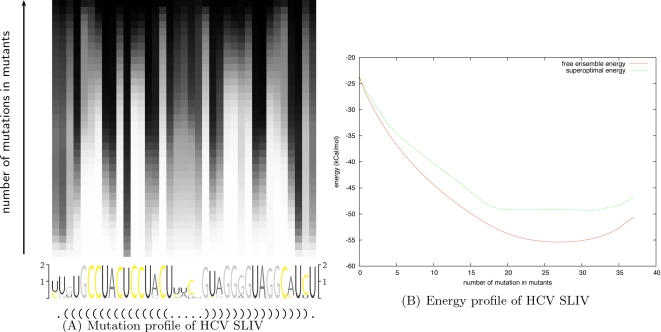
Complete mutation landscape of Hepatitis C virus stem-loop IV (HCV SLIV).(A) Mutation profile of HCV SLIV, averaged over all 110 seed sequences from Rfam, which depicts the probability of mutation of a residue at a level k (i.e. among all k-point mutants). This profile corresponds to a 37×37 matrix M = (mx,y), where x denotes the position within the input HCV SLIV sequence (x-axis) and y denotes the mutation level or number of mutations (y-axis). Mutation frequency computed from sampled structures is represented as a gray level: probability of 1 is depicted as black while probability of 0 is depicted as white, and values of y increase from bottom to top. Sequence logo and the consensus secondary structure from the Rfam seed alignment appear below the mutation profile. (B) Superposition of k-superoptimal free energy and k-mutant ensemble free energy, as computed by RNAmutants; the x-axis represents the number of mutations and the y-axis represents free energy in kcal/mol. Note that the k-mutant ensemble free energy −RI ln Zk is lower than the k-superoptimal free energy, a situation analogous to the fact that the ensemble free energy −RI⋅ln Z is lower than the minimum free energy in the output of RNAfold. This may seem paradoxical, unless one realizes that ensemble free energy is not the same as the mean free energy μ = ΣS E(S)⋅exp(−E(S)/RI)/Z, the latter which can be computed by the method of [53] or by the classical statistical mechanics formula
[33].